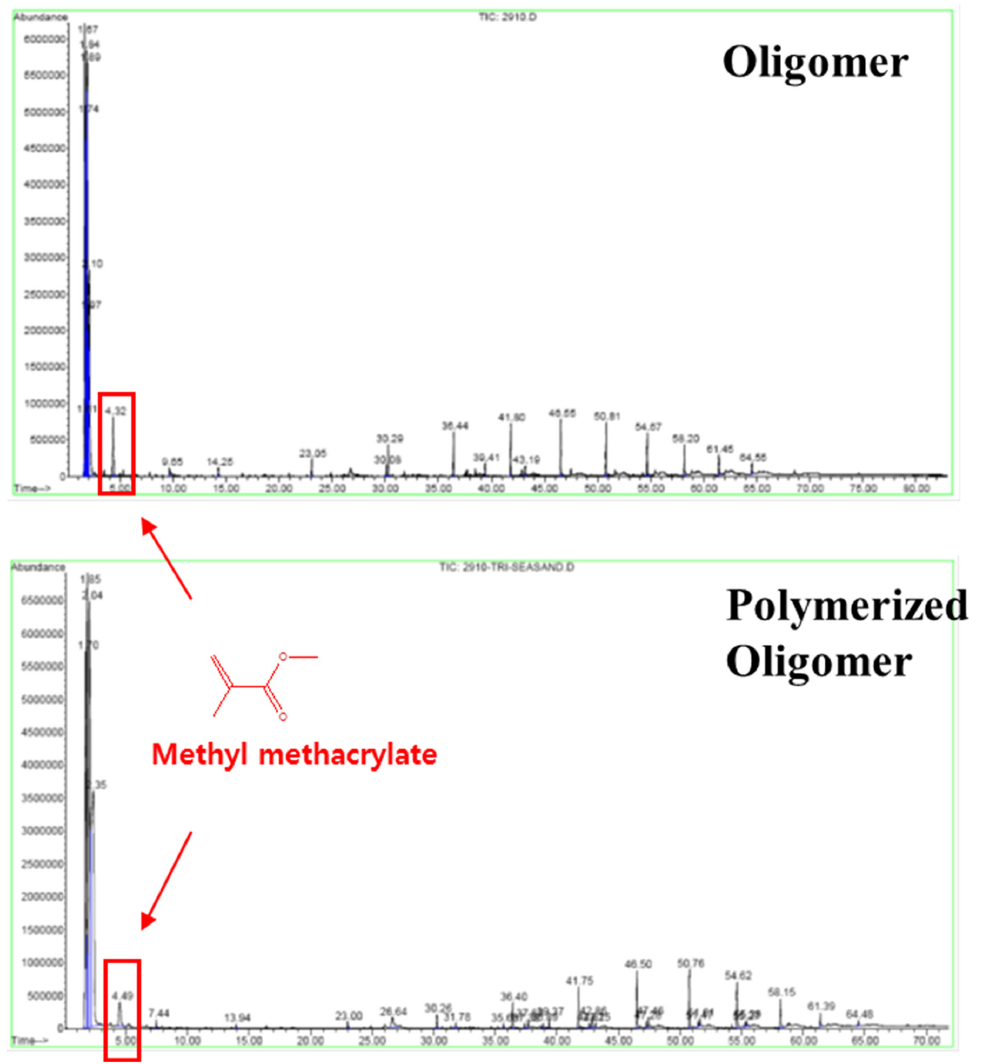
Figure 5. Pyrolysis gas chromatography (GC) chromatogram of oligomer and polymerized oligomer with spectrum representing methyl methacrylate.